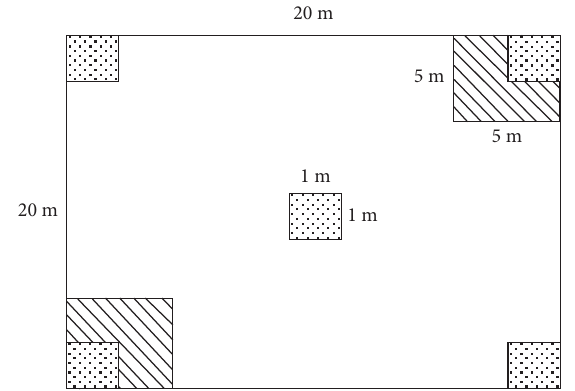
Figure 3: Sampling design used for data collection [44]. Note: subplots (1 × 1m) are measured for herbs, grasses, and soil samples; subplots (5 × 5 m) are measured for shrubs and lianas, and the main plot (20 × 20 m) is measured for trees, saplings, and